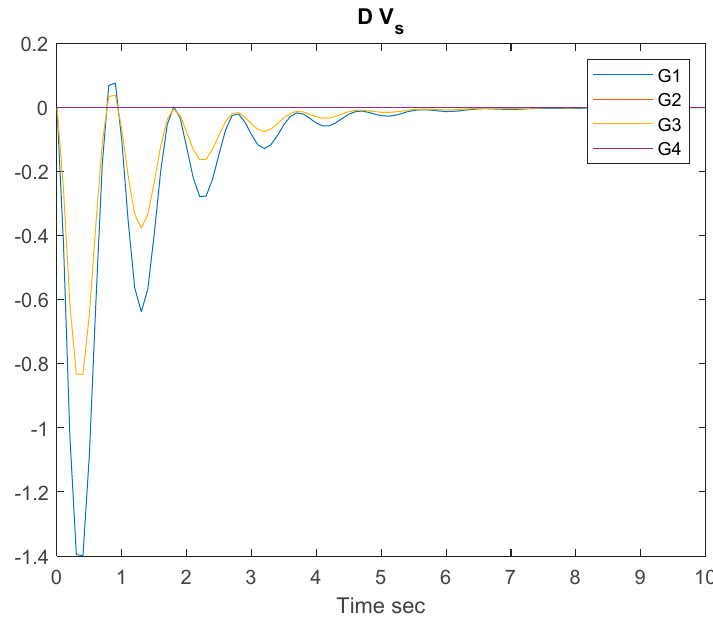
Figure 8. ∆ v 2 Variations diagram of generators in a power Δv Variations diagram of generators in a power system. Figure 8. 2